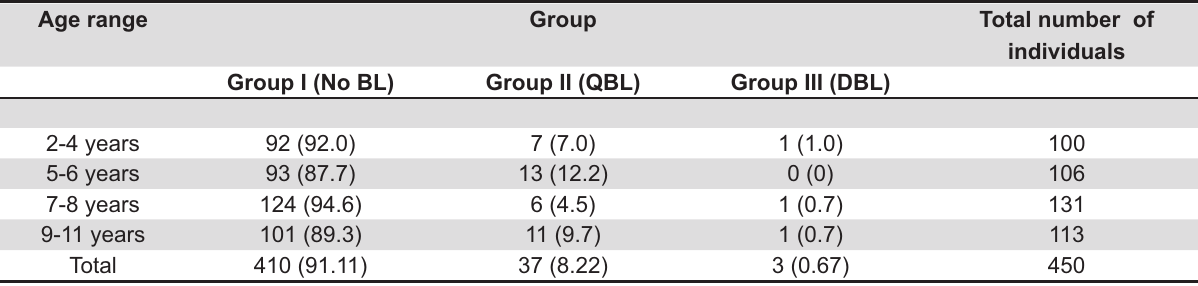
Table 3- Group composition according to patients’ age ranges related to Bone Loss